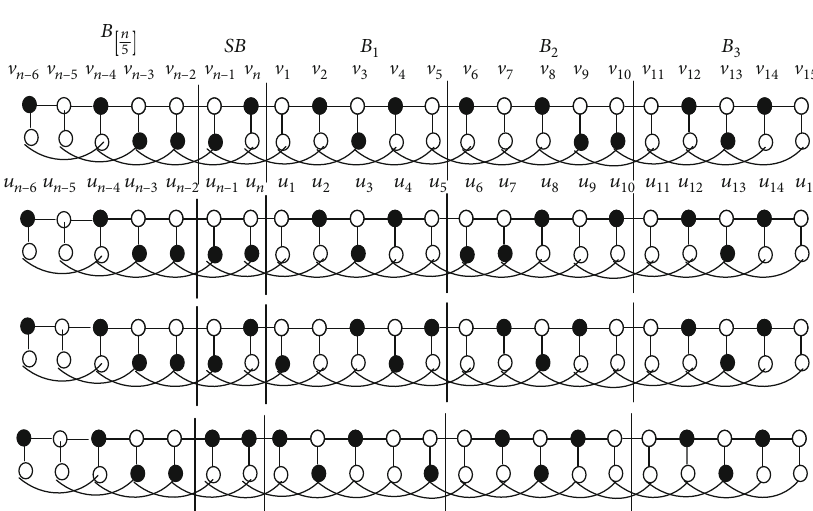
, B , SB with 9 1 2